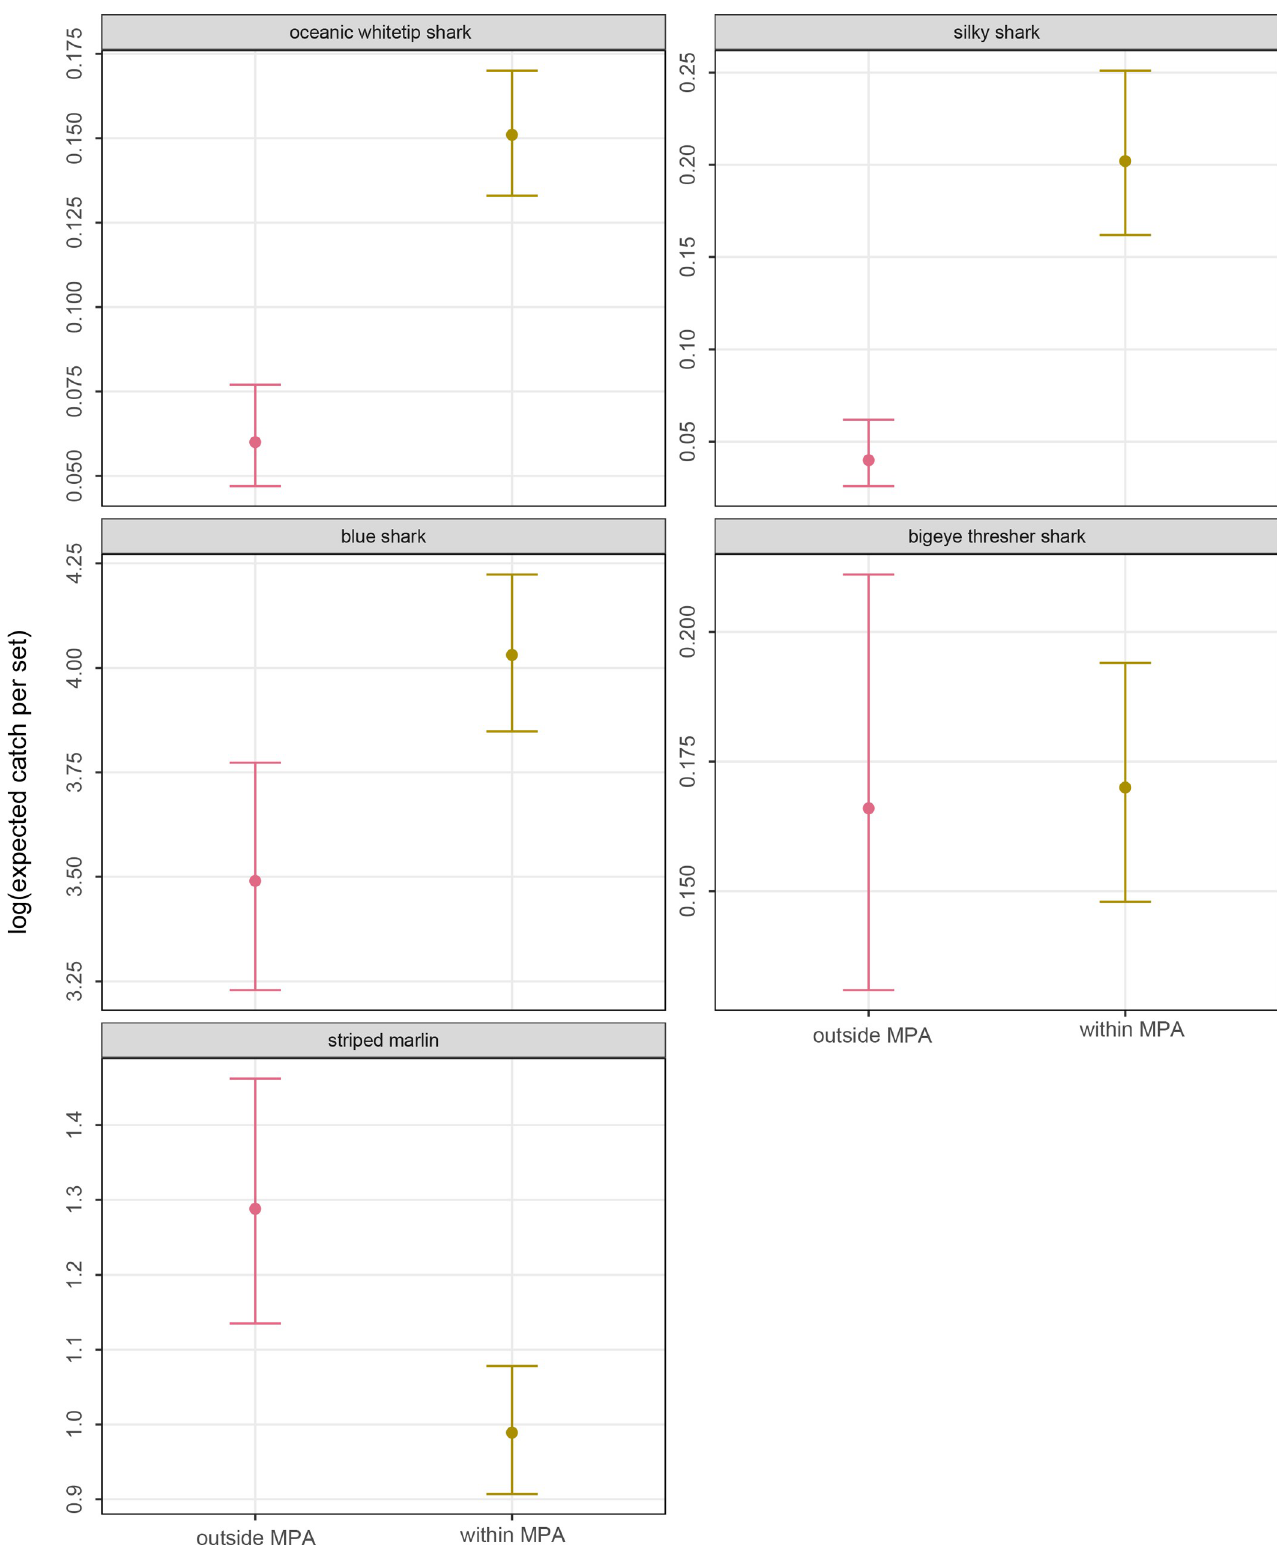
Fig 3. Comparison of the estimated mean catch rates inside and outside of the combined MPAs (Kingman/Palmyra and Johnston) for 5 species of conservation concern derived using species-specific GAMM regression models with negative binomial likelihood fitted to the set-specific catch data. Solid dot shows the expected mean rate and the vertical bar shows the 95% confidence interval. https://doi.org/10.1371/journal.pone.0235129.g003 PLOS ONE | https://doi.org/10.1371/journal.pone.0235129 July 8,